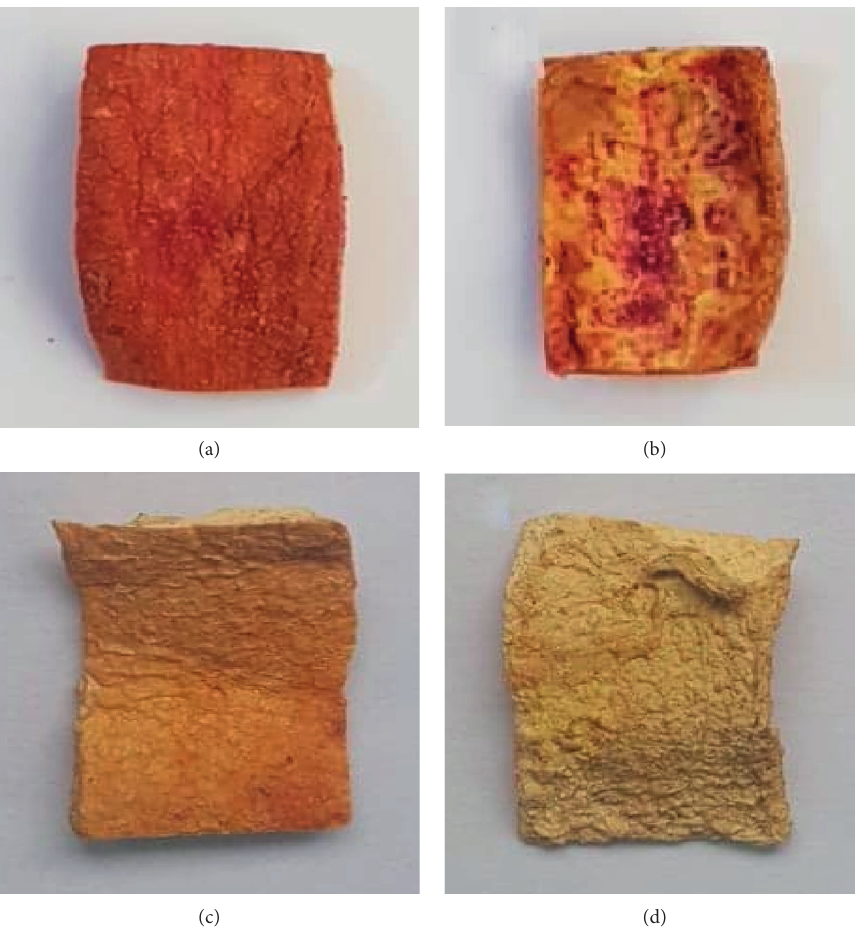
Figure 3: Both sides of raw (a and b) and washed (c and d) pomegranate peel (El Gabsi).